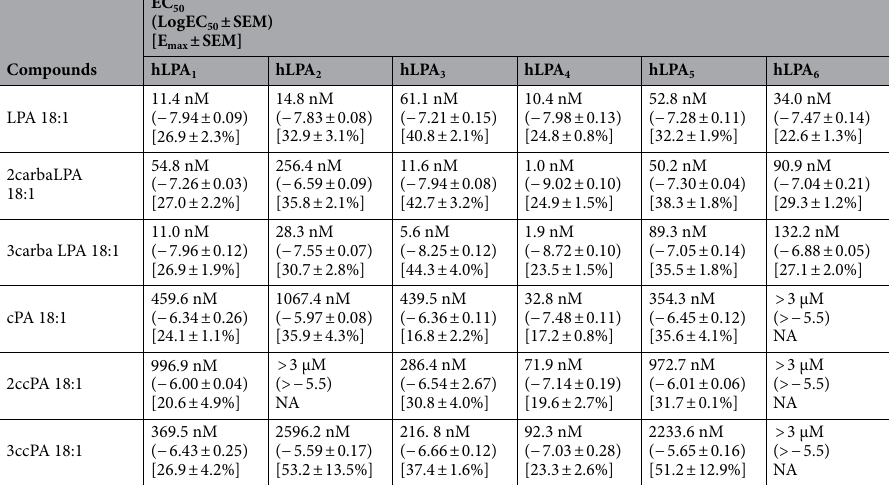
Table 1. Agonistic activity of 2carbaLPA and cPA analogues toward the six human LPA receptors. Data are represented as the mean of three independent replicates. 2carbaLPA 2-carba-lysophosphatidic acid, 2ccPA 2-carba-cyclic phosphatidic acid, 3carbaLPA 3-carba-lysophosphatidic acid, 3ccPA 3-carba-cyclic phosphatidic acid, cPA cyclic phosphatidic acid, hLPA 1–6 human LPA receptors, NA not available because of very low